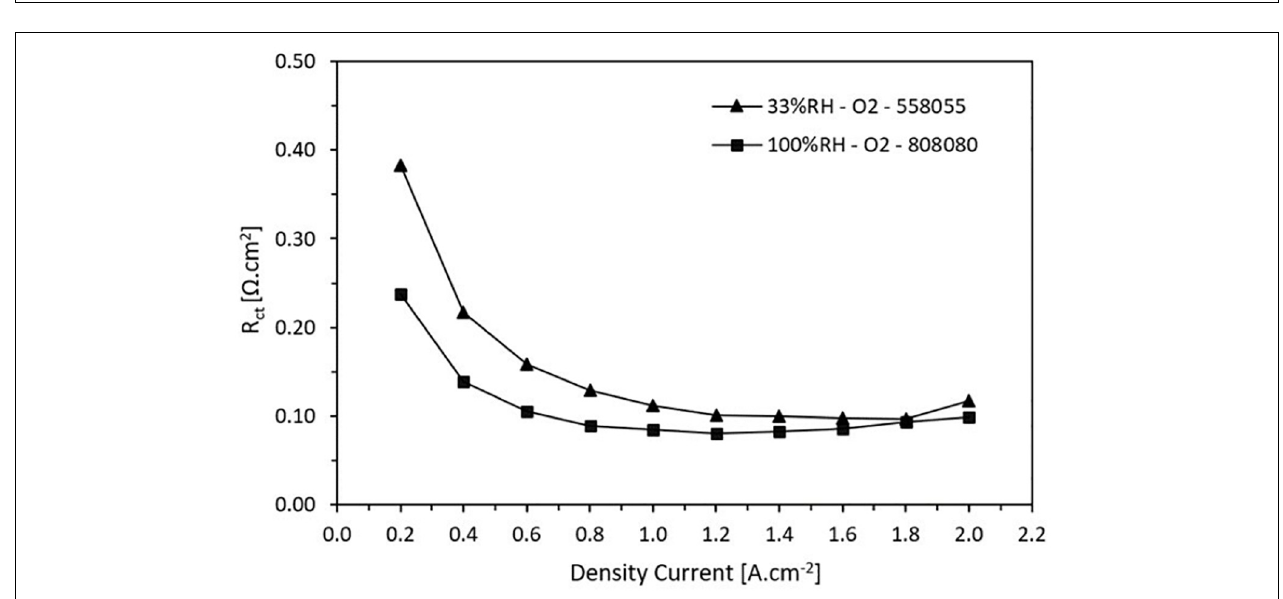
FIGURE 8 | Charge transfer resistance trend in function on the current density for low and high relative humidity.